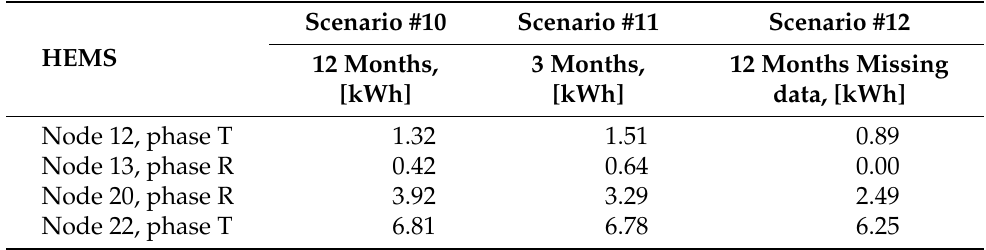
Table 9. Impact of historical data in the flexibility required from HEMS for scenarios A, B, and C.